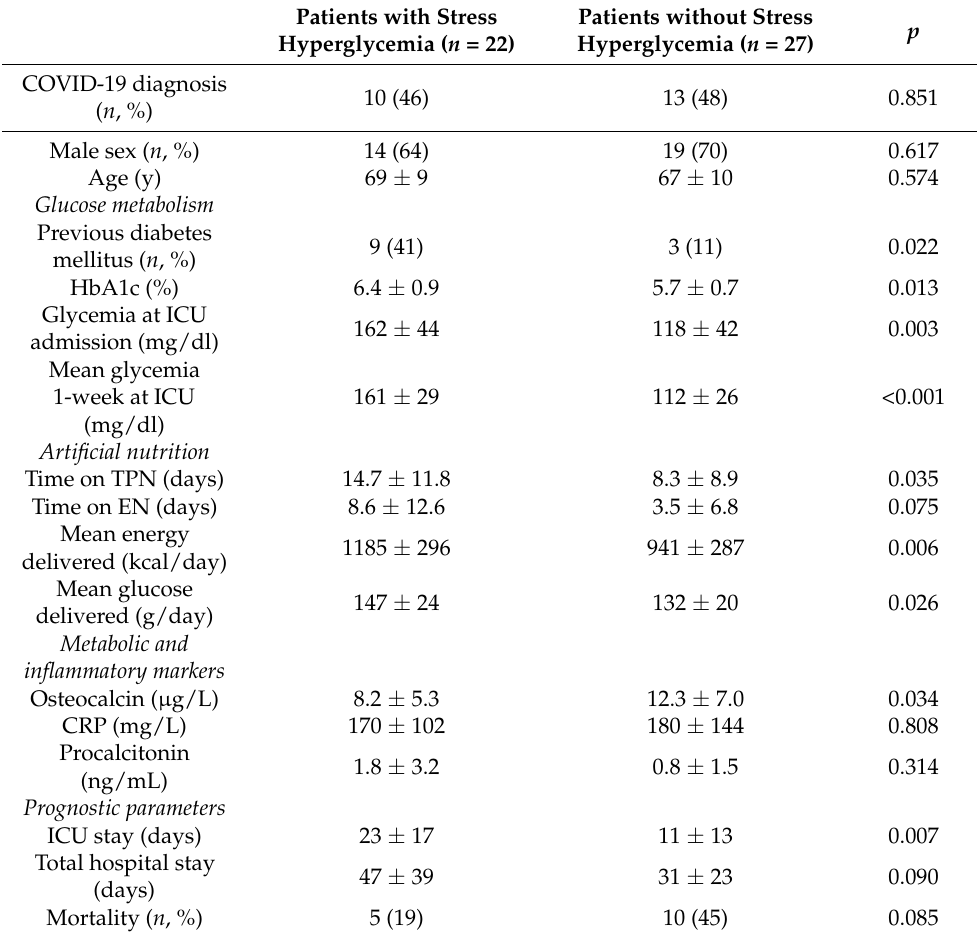
(Table 2). They were on PN for longer, received higher amounts of energy and glucose from artificial nutrition, and showed higher ICU stays. Table 2. Characteristics of patients with and without stress hyperglycemia